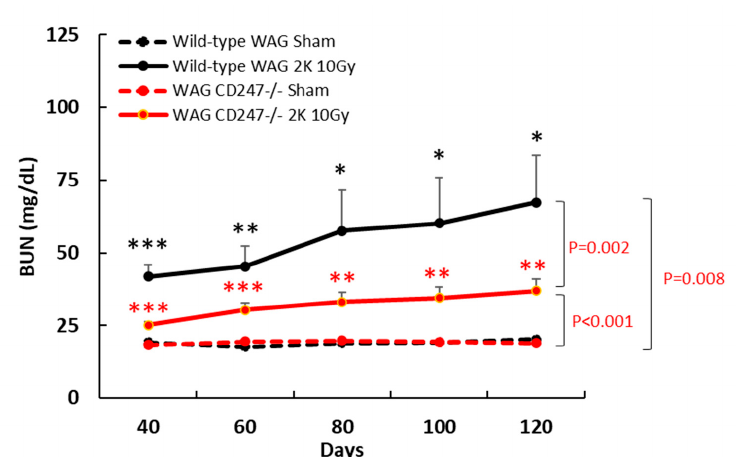
Figure 5. Blood urea nitrogen after local irradiation of the kidneys with 10 Gy of X-rays in wild-type and WAG CD247-/- rats. BUN levels 40–120 days after the start of the study. Data are mean + SEM. n = 6/group. * = p < 0.05 vs. wild-type. ** = p < 0.01 vs. wild-type. *** = p < 0.001 vs. wild-type.